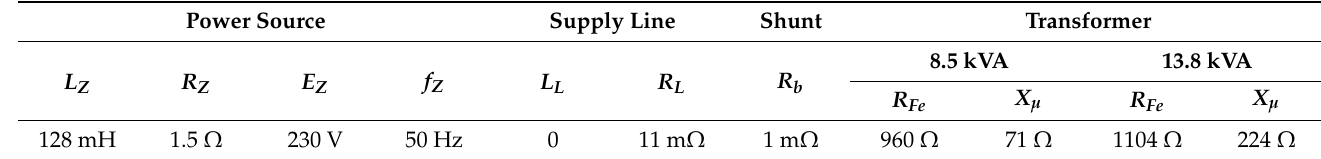
Table 3. Electrical circuit parameters.